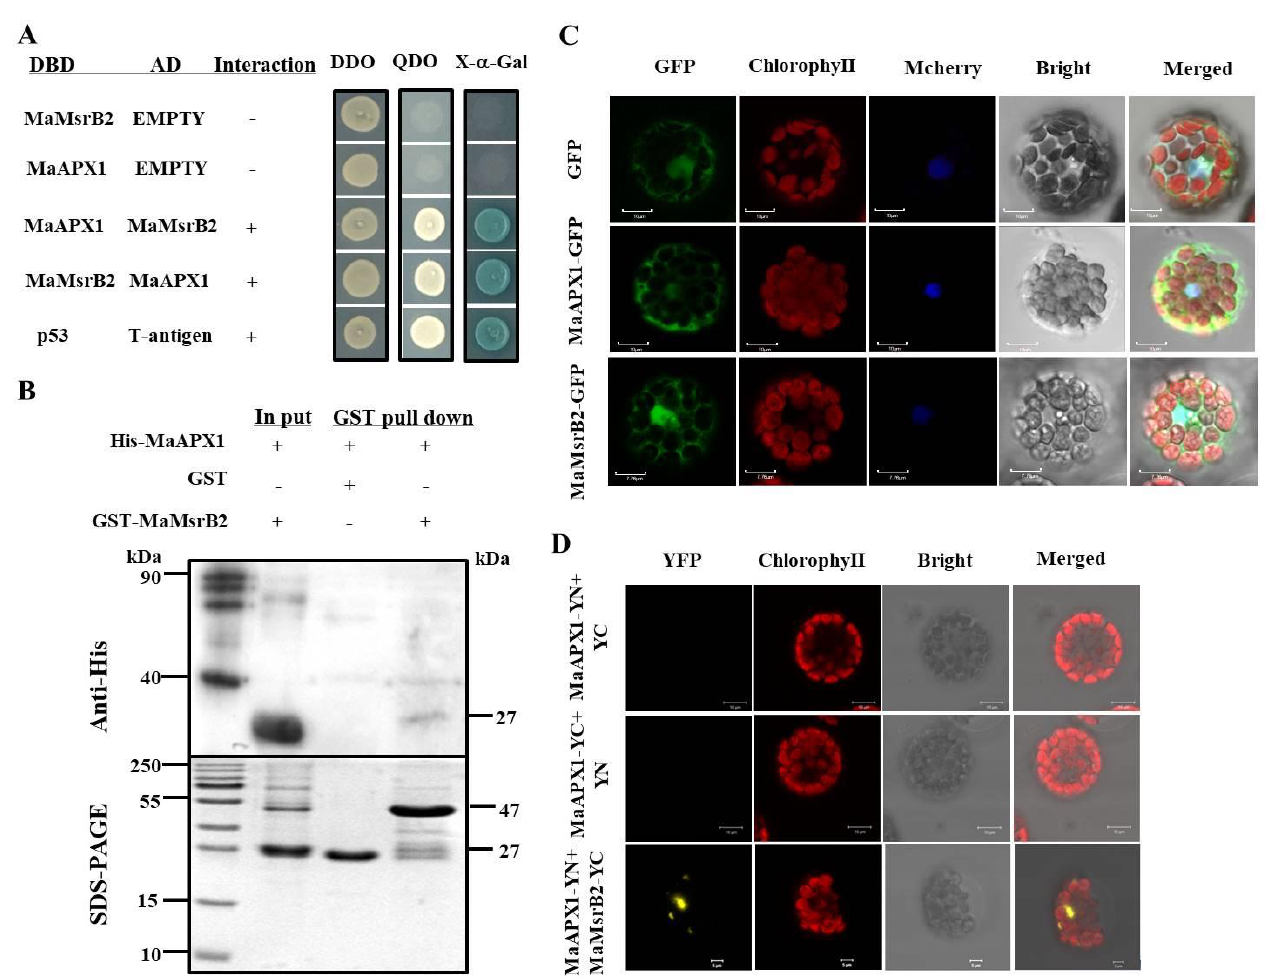
Figure 3. MaAPX1 interacts physically with MaMsrB2. ( A ) Interaction between MaAPX1 and MaMsrB2 in the yeast two-hybrid (Y2H) assay. ( B ) Interaction between MaAPX1 and MaMsrB2 in GST pull-down assay. The molecular weight of MaAPX1-His and MaMsrB2 is about 27-kDa and 47-kDa, respectively. ( C ) Subcellular localization of MaAPX1 and MaMsrB2. A green signal indicates green fluorescent protein (GFP) fluorescence; A red signal indicates chlorophyll auto fluorescence; The merged images represent a digital combination of chlorophyll auto fluorescence and GFP fluorescent images. ( D ) Interaction between MaAPX1 and MaMsrB2 in the bimolecular fluorescence complementation (BiFC) assay. A yellow signal indicates yellow fluorescent protein (YFP) fluorescence; a red signal indicates chlorophyll autofluorescence; the merged images represent a digital combination of the chlorophyll autofluorescence and YFP fluorescent